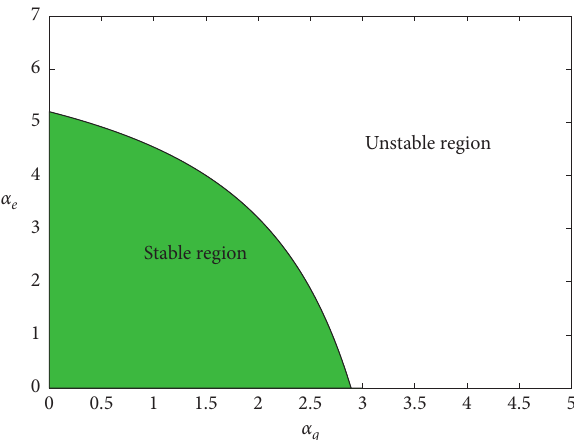
Figure 1: The stable region regard to α